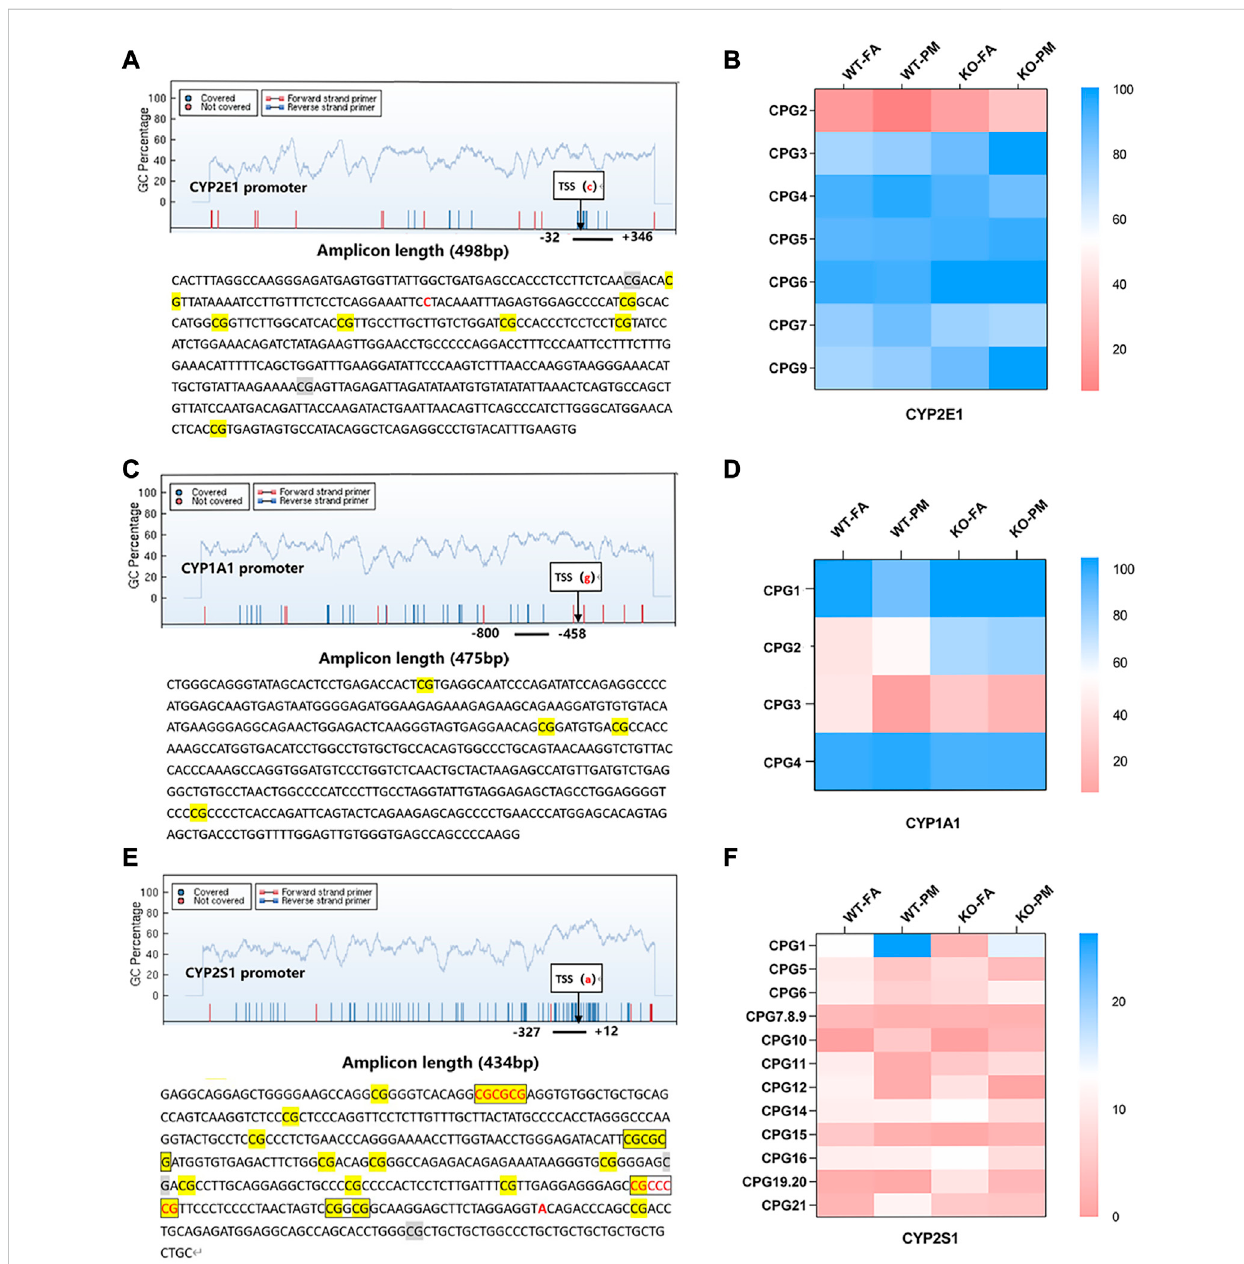
MassARRAY detects methylation levels in the CYP450 promoter; EpiTYPER was used for methylation sequence analysis of promoter selected sites. (A) MethylationunitsandsequencesoftheCYP2E1 promoterregion. (B) Heatmapsofthemethylationlevels of7CpGunitsofCYP2E1 infourgroups. n = 3 per group. (C) Methylation units and sequences of the CYP1A1 promoter region. (D) Heat maps of the methylation levels of the 4 CpG units of CYP1A1. n = 3 per group. (E) Methylation units and sequences of the CYP2S1 promoter region. (F) Heat maps of the methylation levels of 12 CpG units